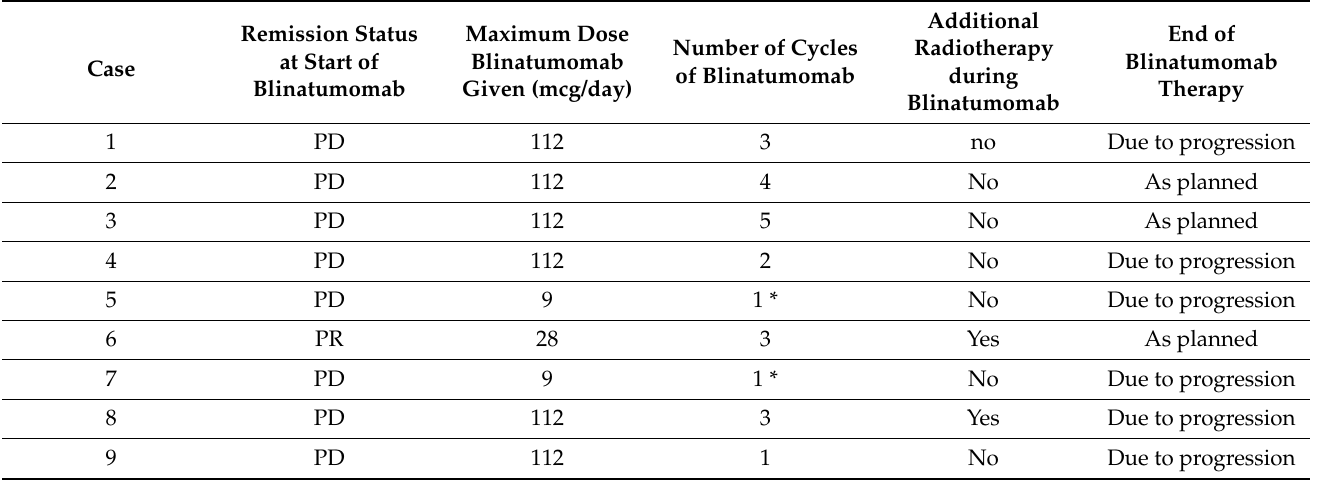
Table 3. Blinatumomab therapy.